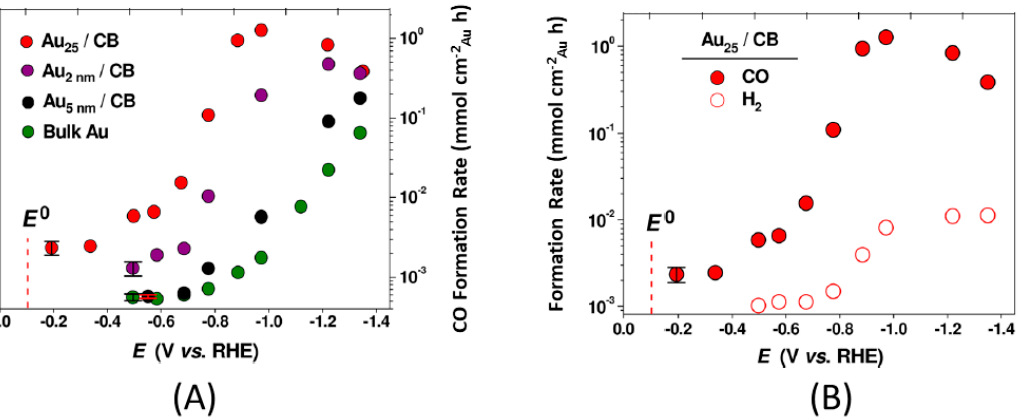
Figure 1. ( A ) Potential-dependent FE for CO on Au 25 (SR) 18 − nanoclusters, Au nanoparticles of 2 and 5 nm size, and bulk gold electrode. ( B ) Potential dependent FE for CO and H 2 formation on Au 25 (SR) 18 − nanoclusters. Adapted from Reference [39]. Copyright 2012 by the American Chemical Society.